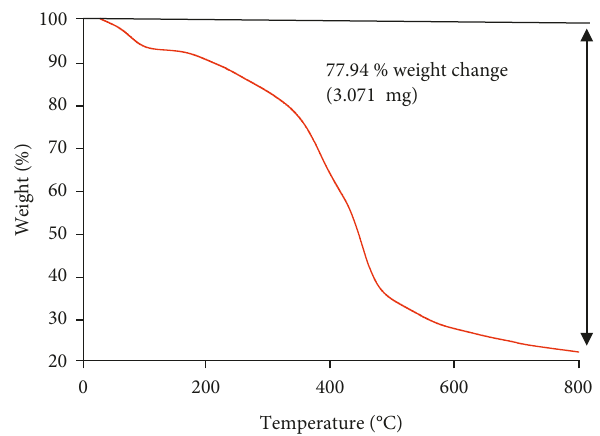
Figure 7: Thermogravimetric analysis of selenium